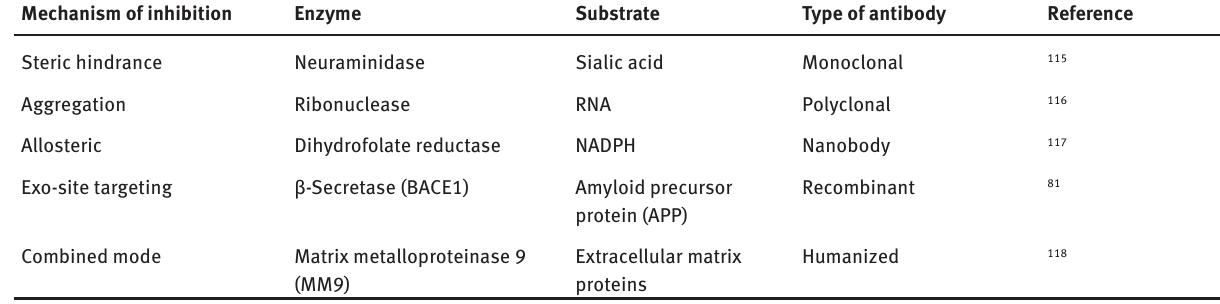
Table 4 : Examples of different mechanisms of enzyme inhibition by antibodies.